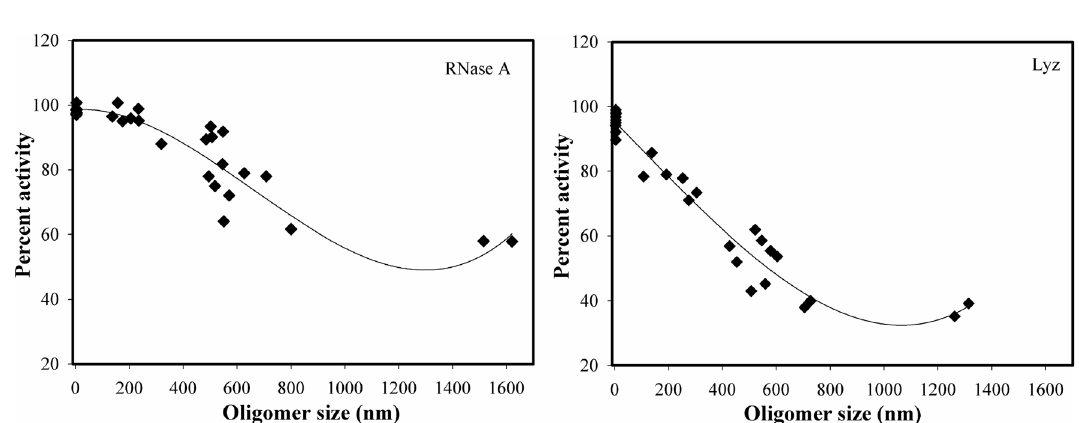
Figure 8. Relation between functional activity and size of oligomers: Plot of enzyme activity versus oligomer size of HTL-modified RNase-A (left panel) and Lyz (right